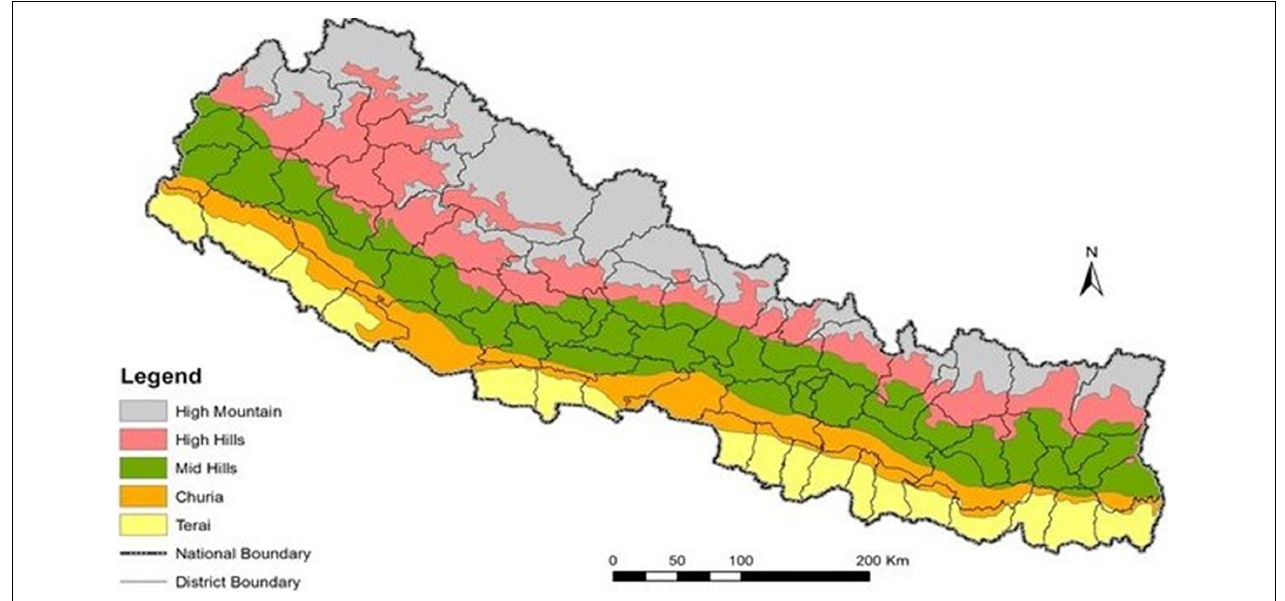
FIGURE 1 | Physiographic zones of Nepal. Source: S. Lamichhane, SSD, NARC; Data from Department of Survey 1996.